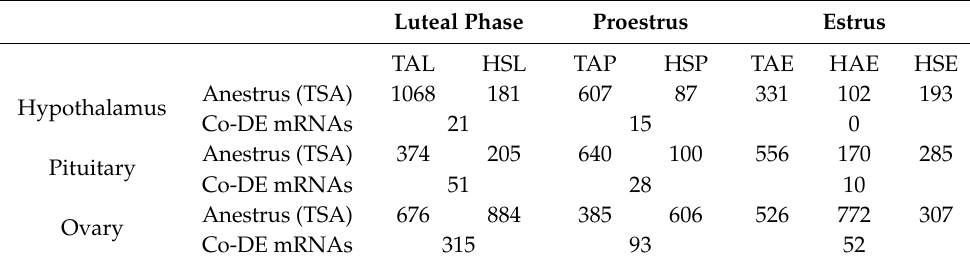
Table 1. The number of DE mRNAs of two breed sheep in hypothalamus, pituitary, ovary in different period.